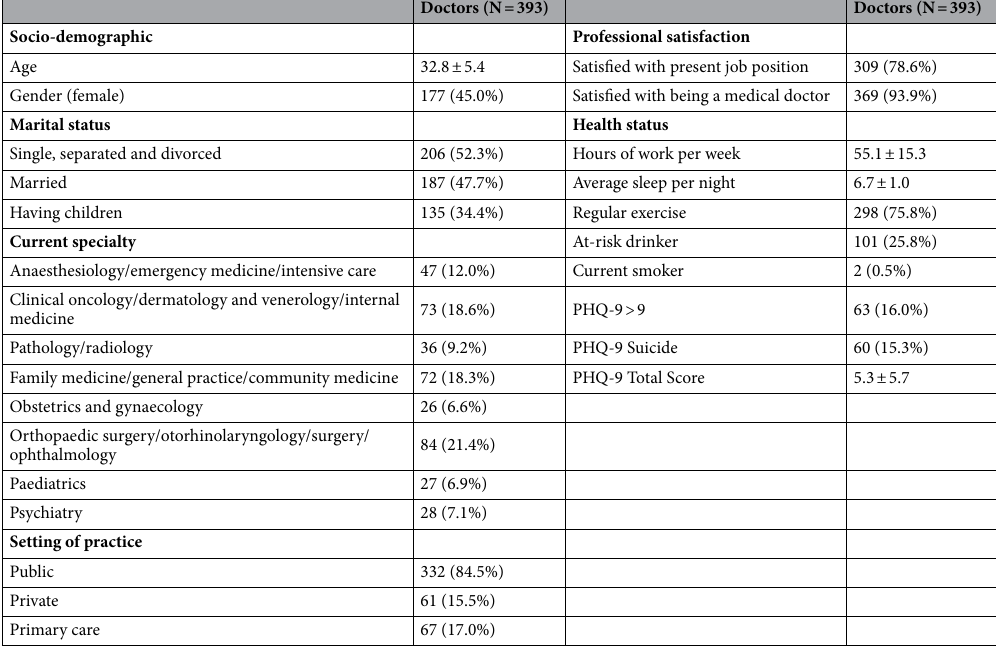
(Table 4). Apart from marital status and hours of sleep, no other socio-demographic factors, professional satis- faction or other lifestyle behaviours were significantly associated with suicidal ideations and self-harm thoughts. A sensitivity analysis using the complete case analysis demonstrated similar results compared to the main analy- sis (Supplementary Tables 2–4).